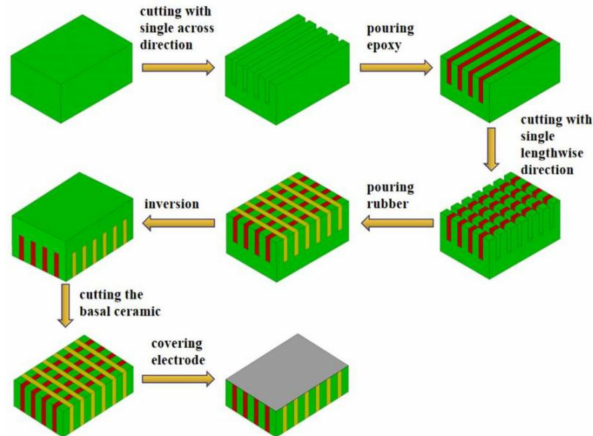
Figure 4. Flow-chart of fabrication of modified 1-3 piezoelectric